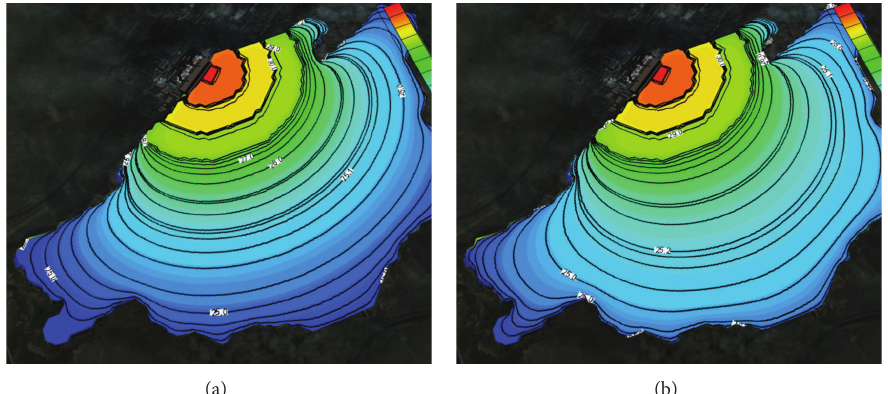
Figure 2: Outline and contours of temperature at 15 and 24 hours after launch of Ekibastuz SDPP-1 on the surface and the top